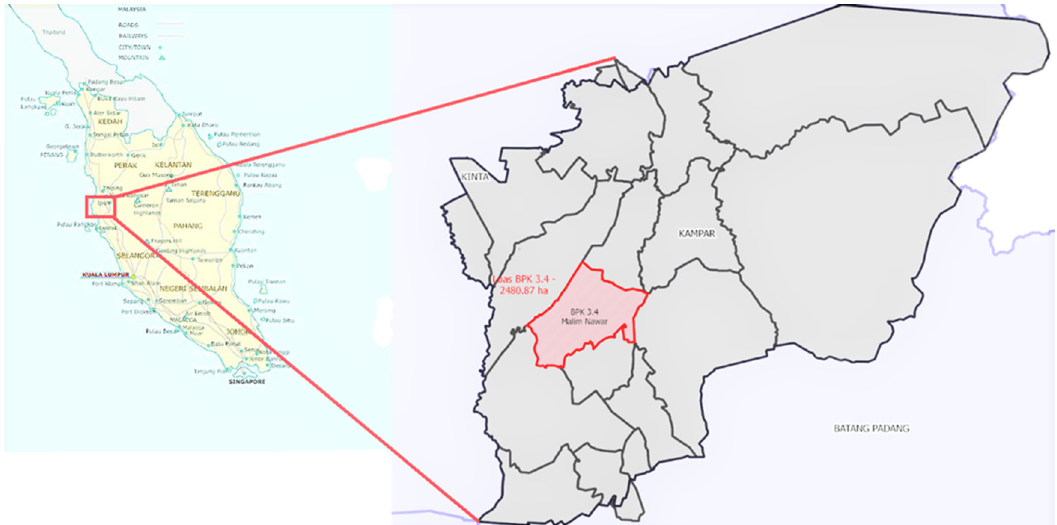
Figure 1: The location of the study site: Malim Nawar in Kampar, Perak,